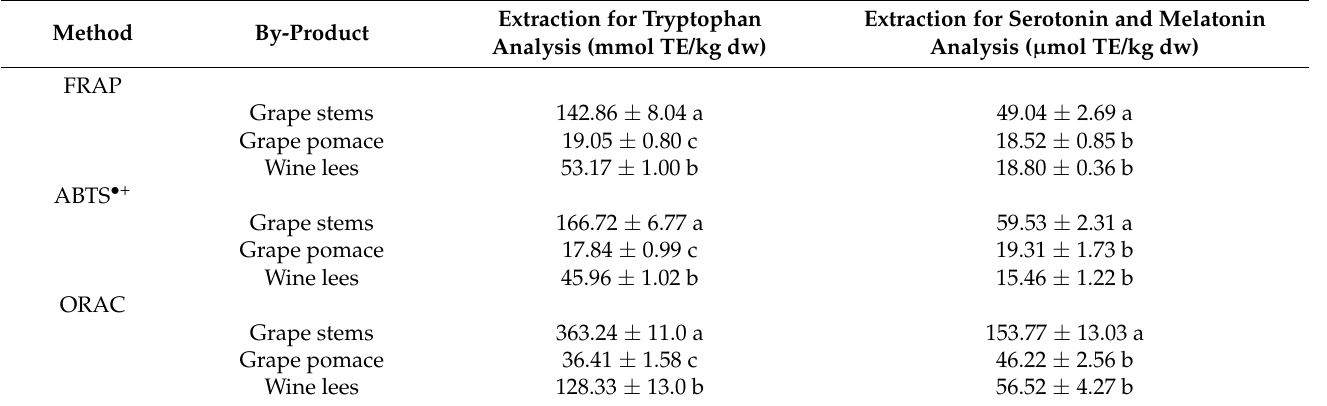
Table 2. Antioxidant capacity in grape stems, grape pomace, and wine lees samples extracted for tryptophan and serotonin/melatonin